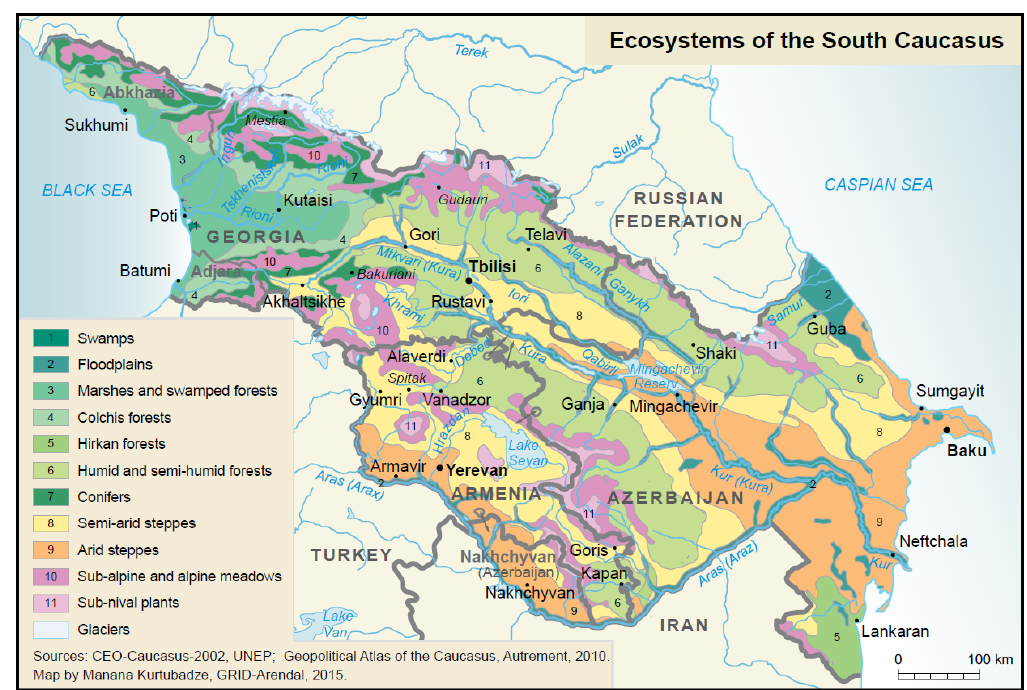
Figure 1. Sampling map.